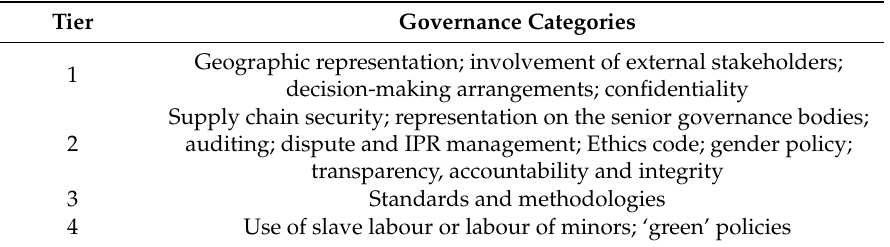
Table 1. Stakeholders’ views on cybersecurity network